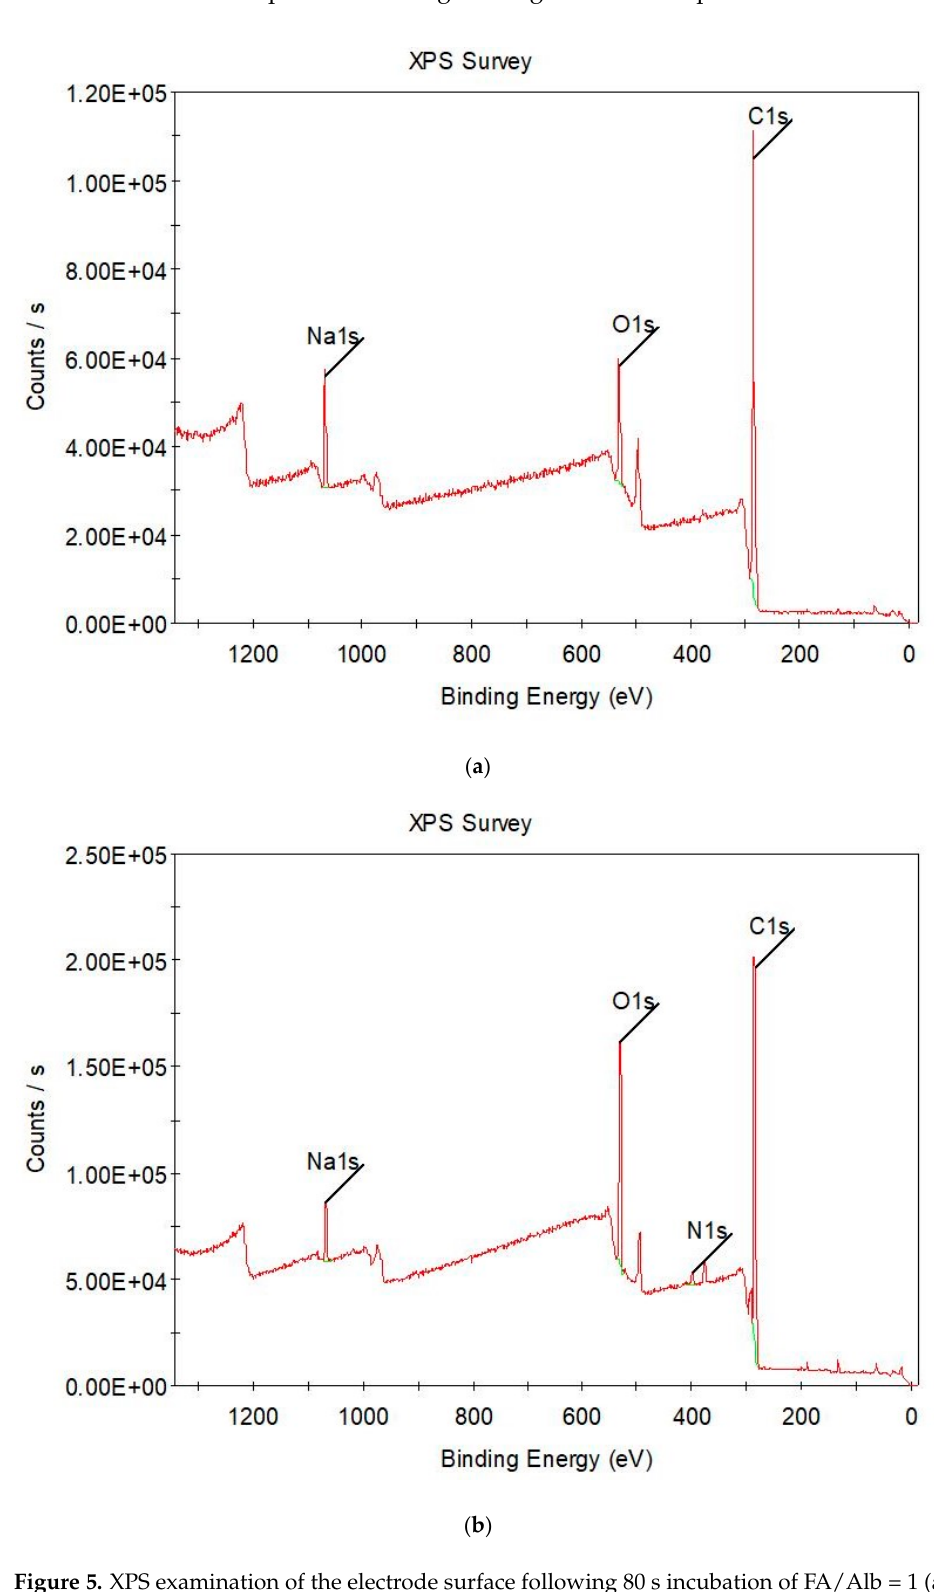
Figure 5. XPS examination of the electrode surface following 80 s incubation of FA/Alb = 1 ( a ) and FA/Alb = 3 ( b ) samples.